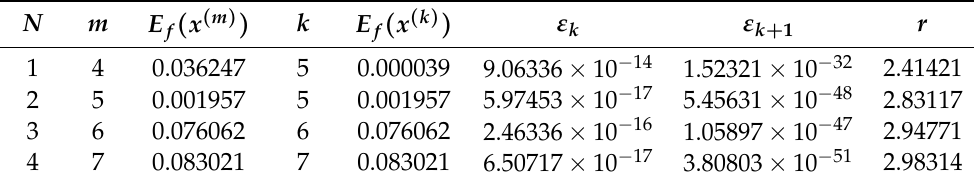
Table 3. Convergence behavior for Example 1 ( R n = 0.125, τ n =